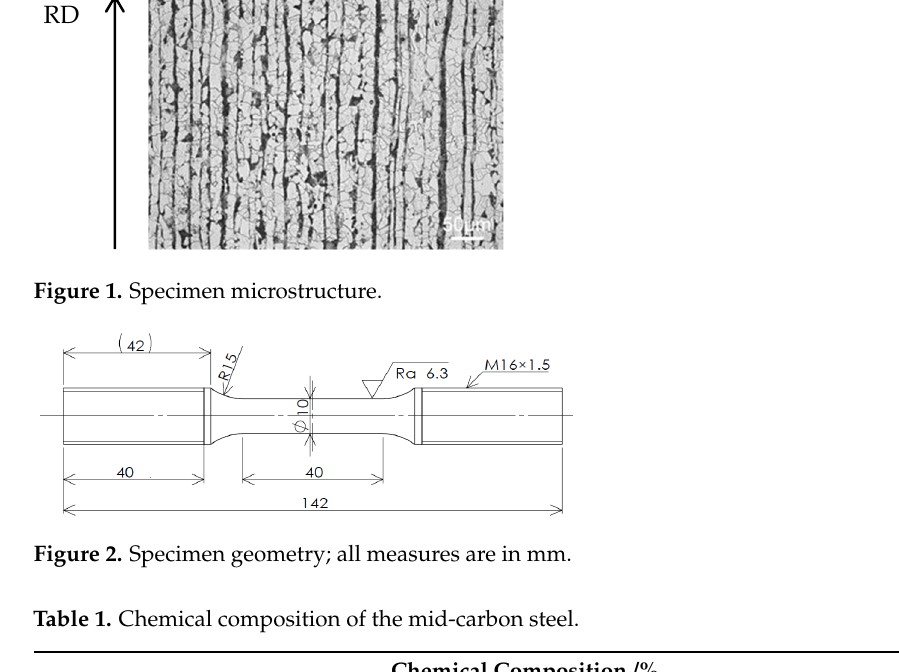
Figure 1. Specimen microstructure.